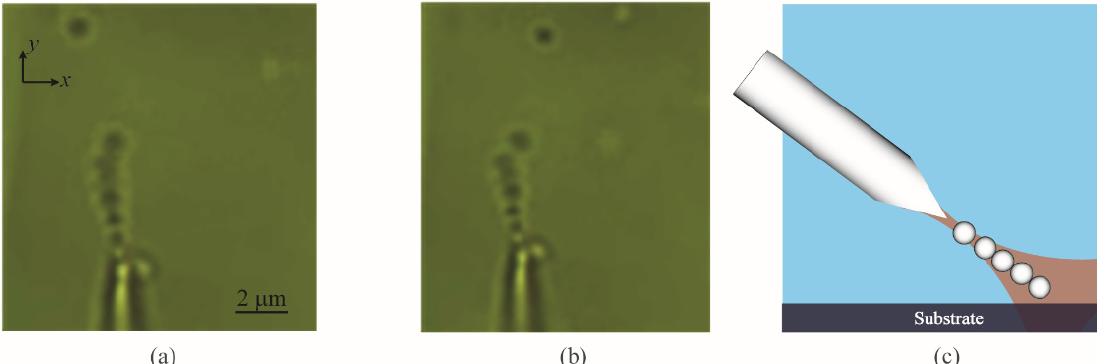
Figure 4. Demonstration of the optical binding effect. ( a ) Eight submicron particles trapped by the single fiber − based trapping system. The first 7 particles are stably trapped while the last one can easily escape from the trap ( b ) due to the weak light coupling. The blurry circle dot at the right − hand side of the fiber tip is a free particle on the cover glass. ( c ) The schematic diagram for trapping multiple submicron particles, due to the optical binding effect, by a single fiber − based system .